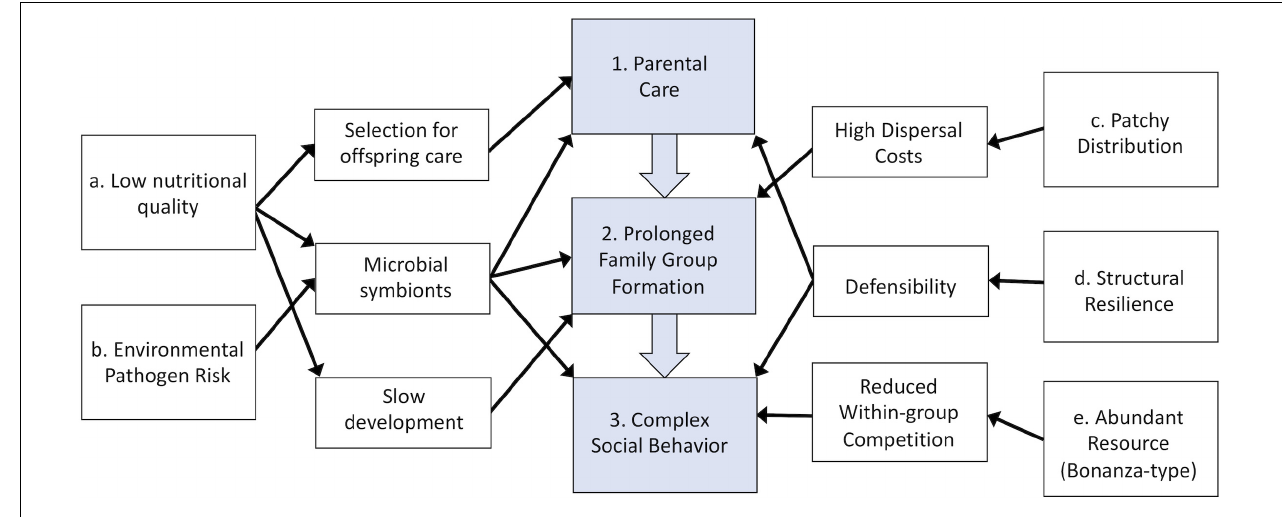
FIGURE 1 | Conceptual diagram of the factors associated with log-habitats that have shaped the evolution of parental care and the transition to more complex family and social groups. The physical properties of the log habitat (boxes a–e) favored the sequential evolution of complex family-based social groups from ancestors with simple parental care (boxes 1–3) by generally favoring prolonged family cohesion and reducing dispersal and independent establishment